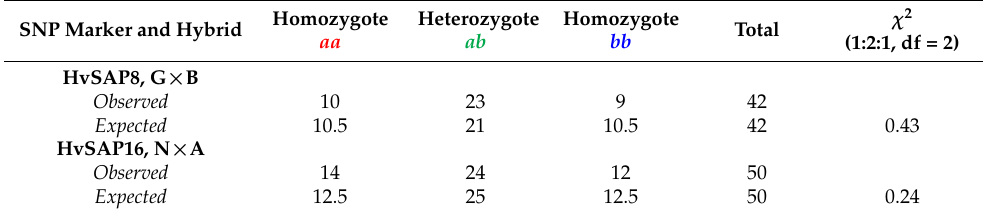
Table 1. Chi-square analysis for genotype segregations with SNP-ASQ markers HvSAP8 and HvSAP16 in two barley hybrid populations.